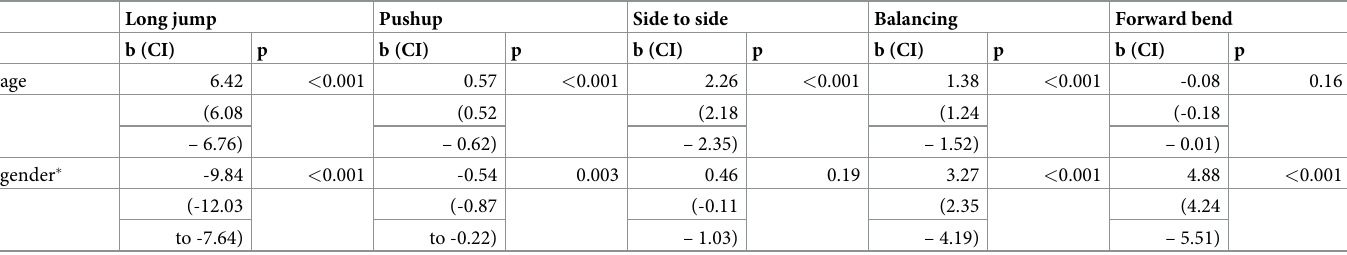
Age and gender were included simultaneously (multivariate regression